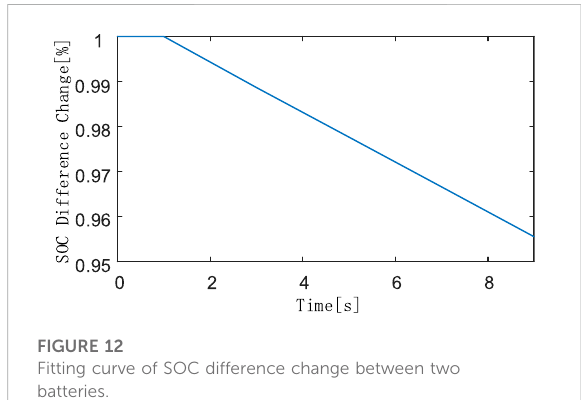
FIGURE 12 Fitting curve of SOC difference change between two